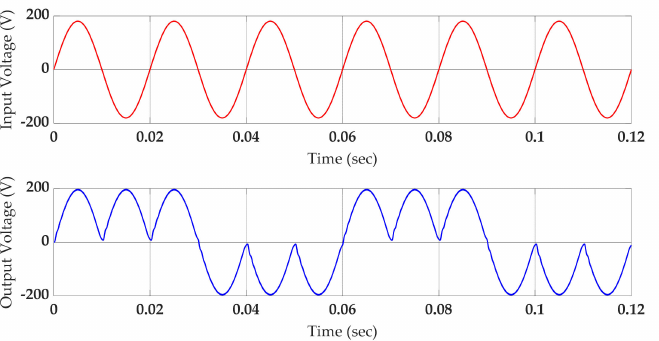
Figure 8. Simulation results for output frequency step-down process with a voltage gain of 1.12.